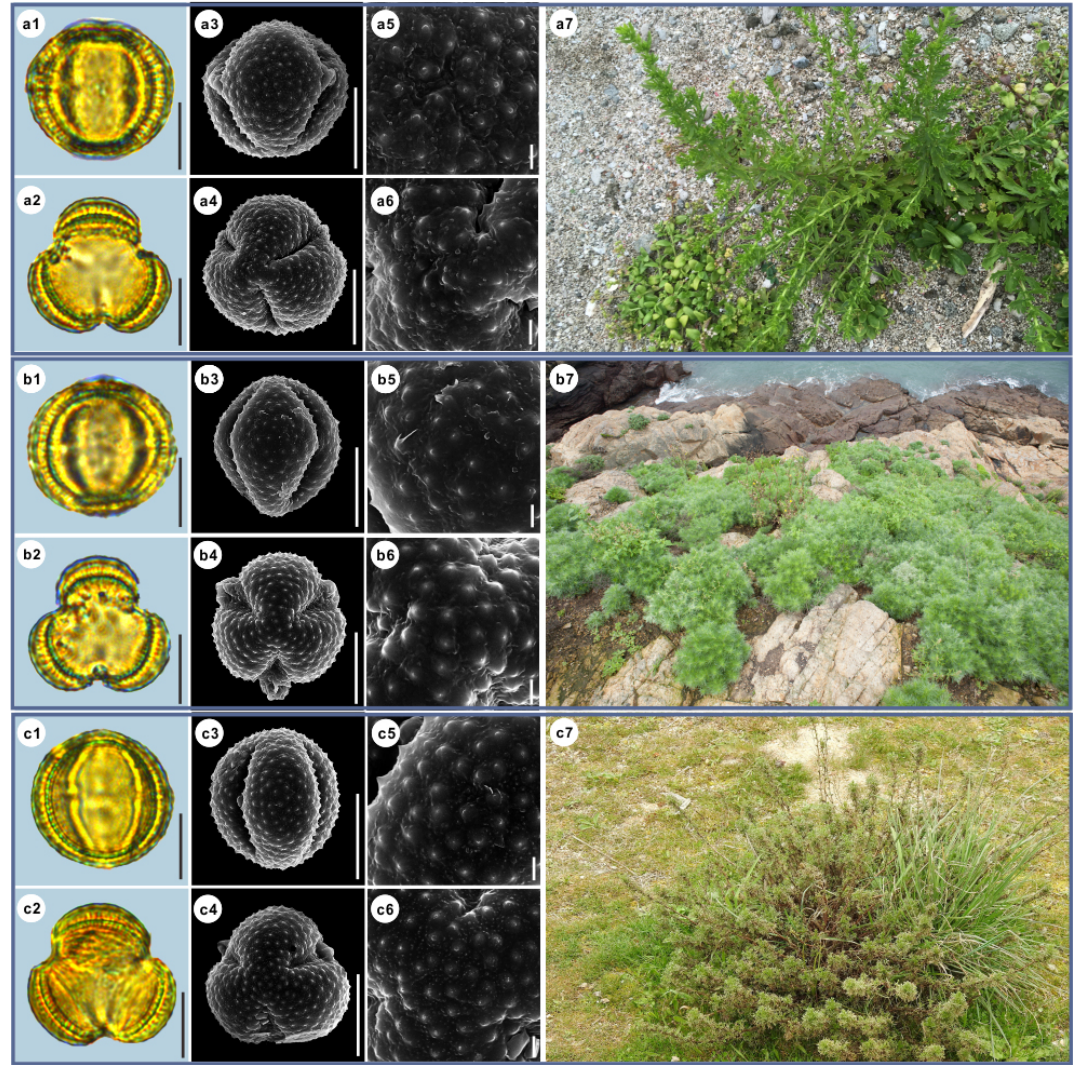
Figure 13. Pollen grains and the habitats of their source plants. (a) Artemisia japonica ; (b) Artemisia capillaris ; and (c) Artemisia campestris . Pollen grains in equatorial view under LM (a1, b1, c1) and SEM (a3, a5, b3, b5, c3, c5) , in polar view under LM (a2, b2, c2) and SEM (a4, a6, b4, b6, c4, c6) , along with the habitats of their source plants (a7 cited from https://www.inaturalist.org/photos/44507659, last access: 19 August 2022, by © , b7 cited from https://www.inaturalist.org/photos/60639286, last access: 19 August 2022, by © Cheng-Tao Lin, c7 cited from https://www.inaturalist.org/photos/113822257, last access: 19 August 2022, by © pedrosanz-anapri ) . Scale bar in LM and SEM overview 10µm, and in SEM close-up